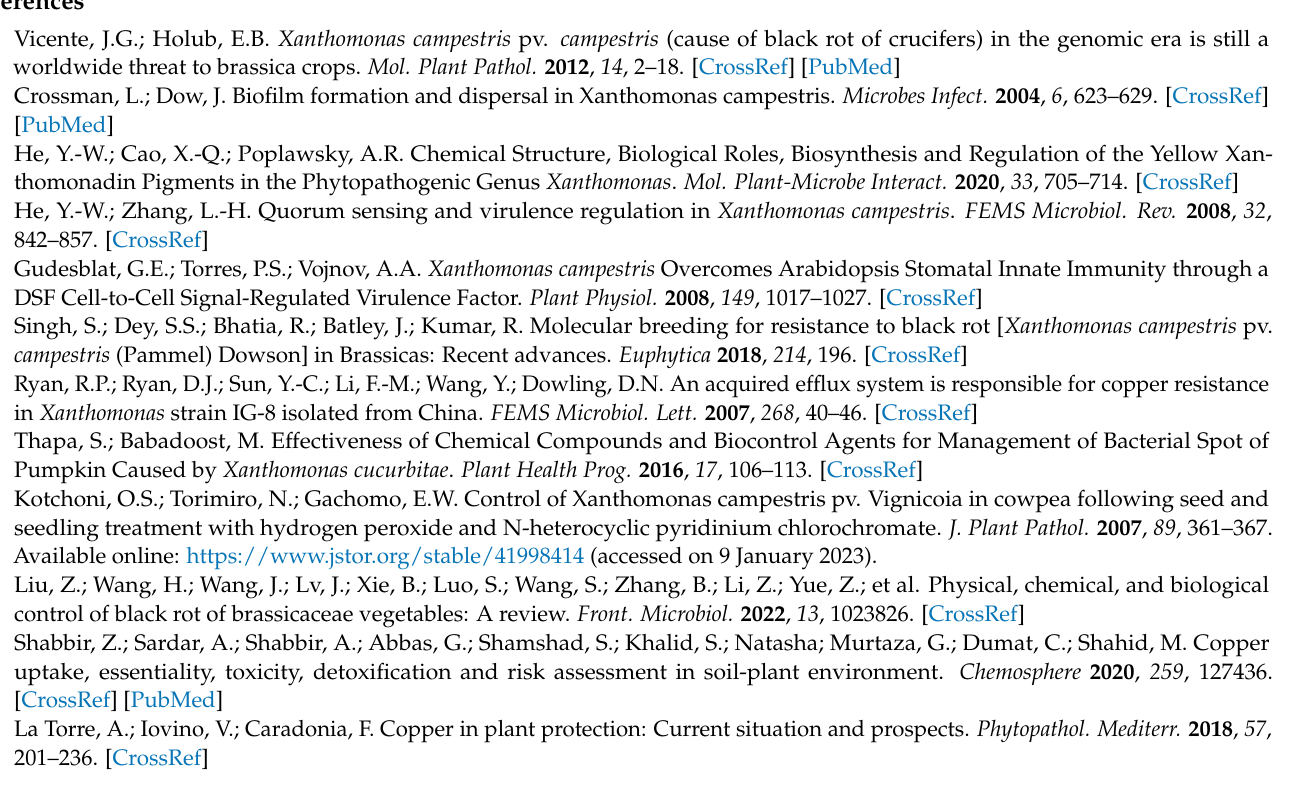
extracts activity; Figure S1: In vitro membrane permeability assay on single strains by single phenols; Figure S2: In vitro biofilm formation assay on single strains by single phenols; Figure S3: In